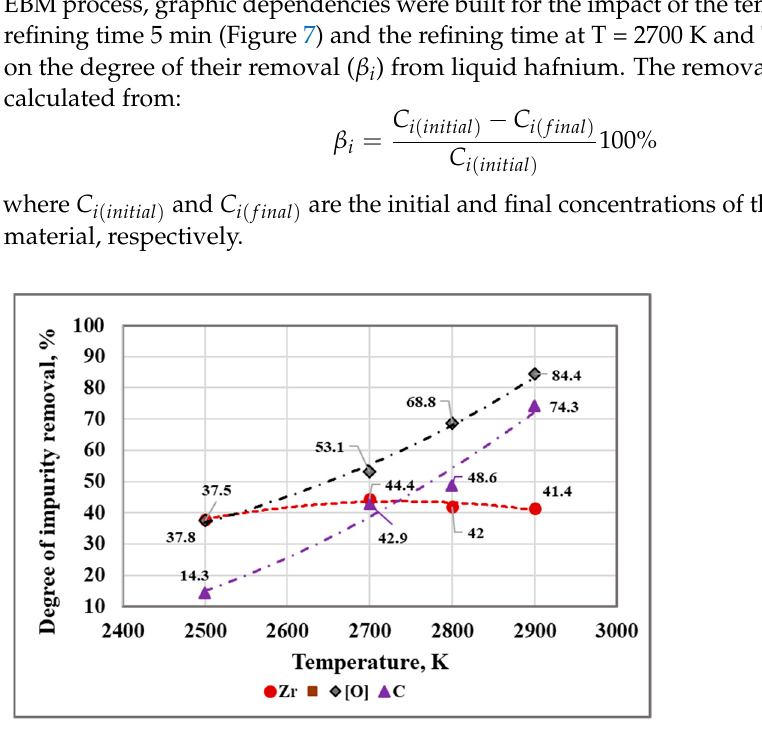
Figure 7. Influence of melting temperature on the degree of impurity removal from technogenic hafnium in vacuum for τ = 5 min.